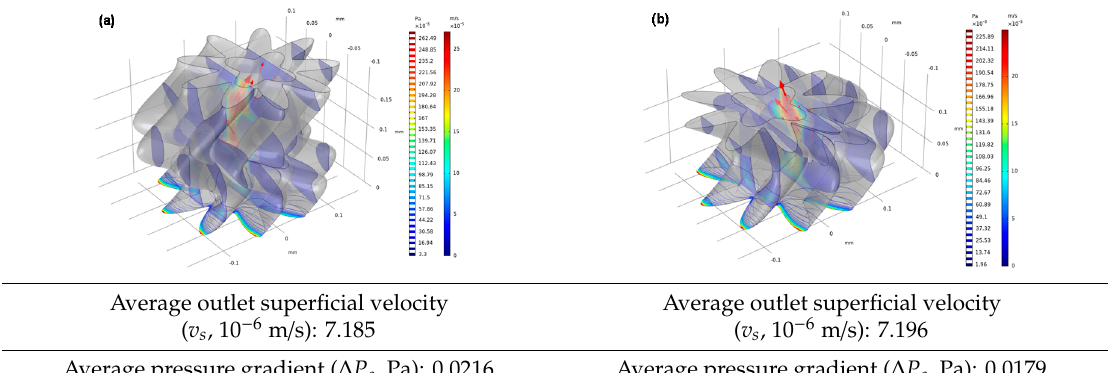
Table 9. Computational results of fluid pressure and velocity field in the pore channel model of Boise sandstone. The tortuosity, average distance and propagation angle of connected pores of ( a ) the total pore phase and ( b ) the apparent pore phase were applied to the 3D flow path geometry.